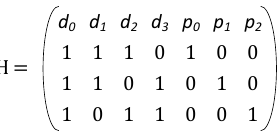
Figure 2. Parity check matrix of a (7, 4) binary Hamming code.